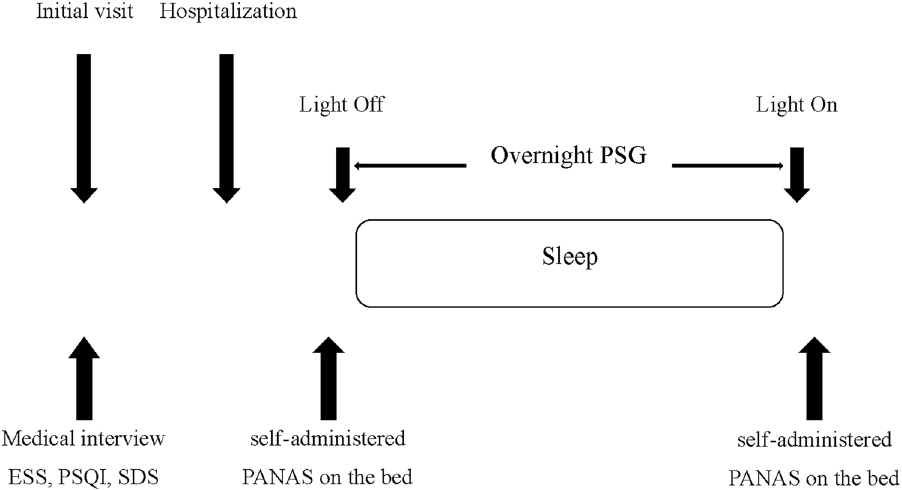
Figure 4. Study protocol. The protocol for this study was as follows: Participants were interviewed at the initial visit and self-administered the ESS, PSQI, and SDS. They also self-administered the PANAS immediately before and after sleep using PSG. ESS, Epworth Sleepiness Scale; PANAS, positive and negative affect schedule; PSG, polysomnography; PSQI, Pittsburgh Sleep Quality Index; SDS, Self-rating Depression